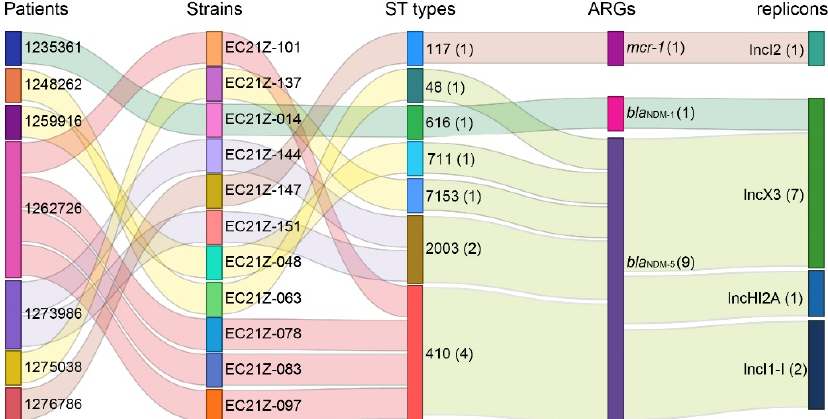
Figure 3. The relationship of the resistant strains from the patient with the ST types, bla NDM-1 , bla NDM-5 , and mcr-1 genes and their bearing plasmids. The strain numbers are marked behind the information with parentheses.